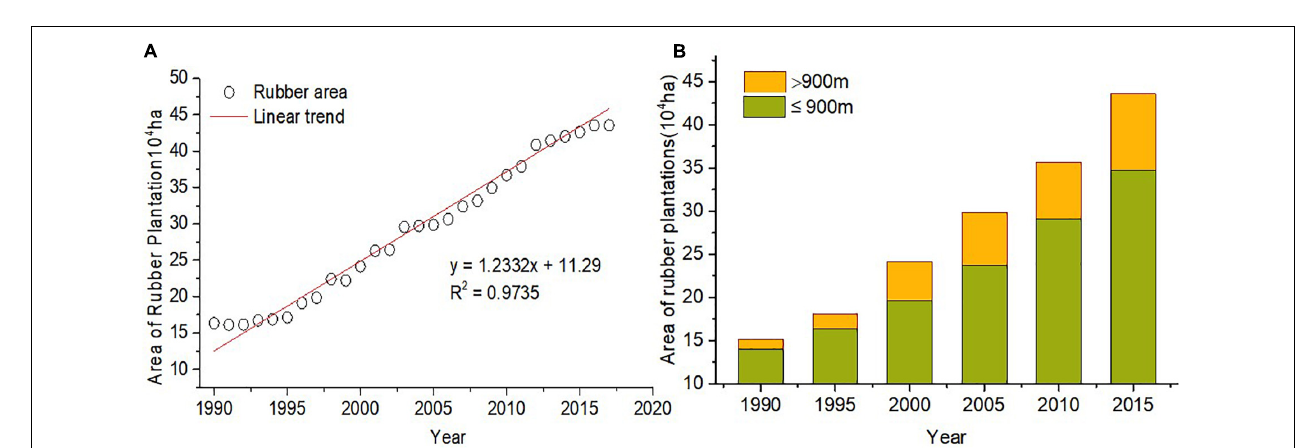
FIGURE 3 | Distribution change of rubber plantations in Xishuangbanna.